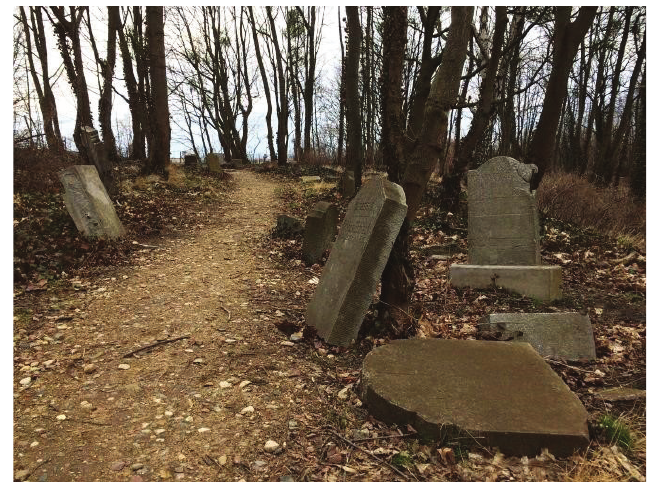
Figure 2. Nostalgic Park – a monument in place of the former urn cemetery in Traugutta Street (so-called forest cemetery). Photo: K.